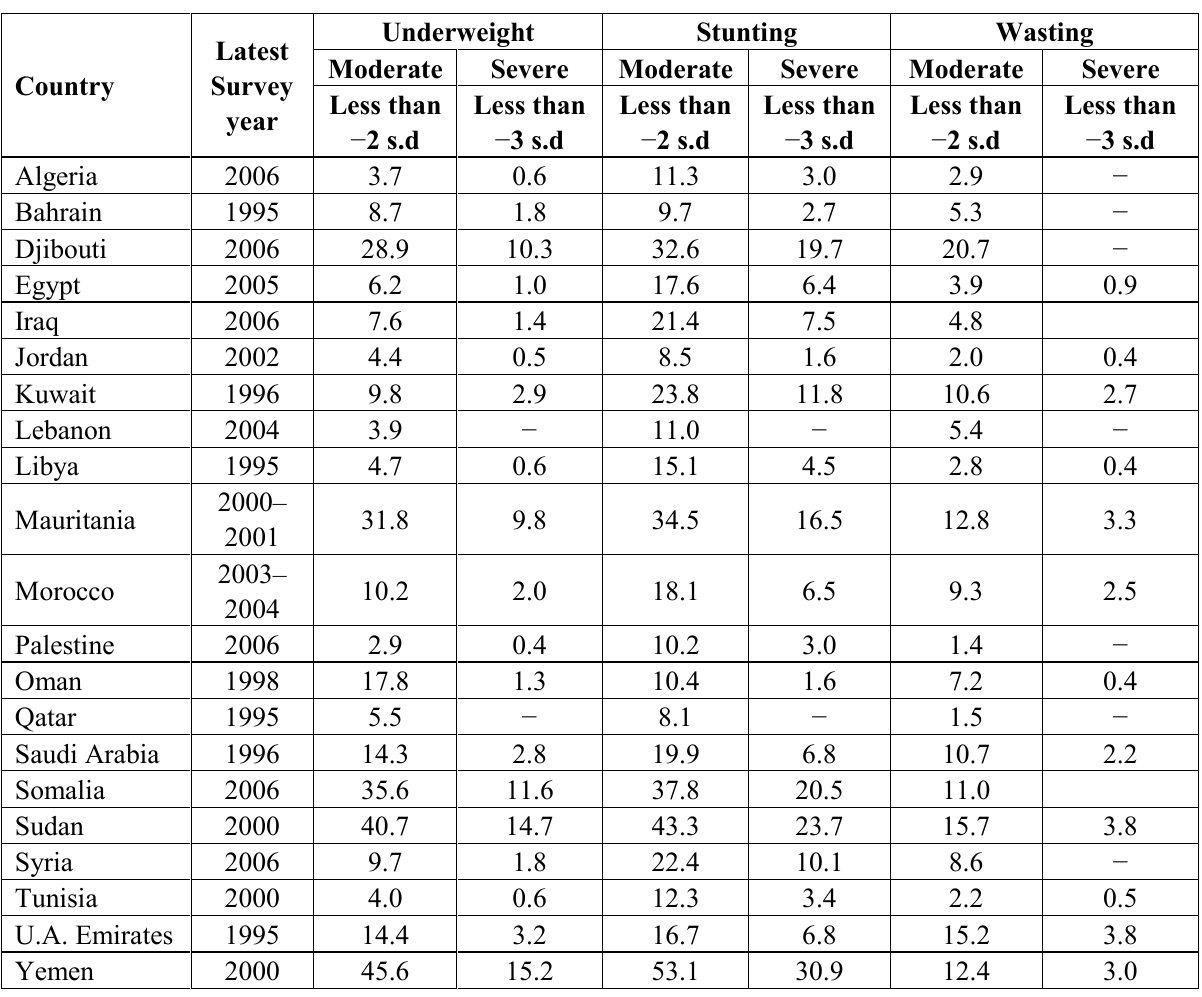
Table 1. Prevalence of under-nutrition in children under the age of five years (%) in the Arab